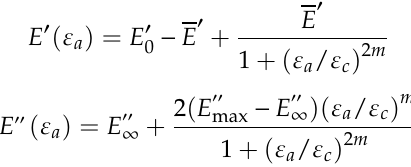
Figure 10. The changing results of strain value ε c corresponding to the maximum loss modulus E” max with the aging time.